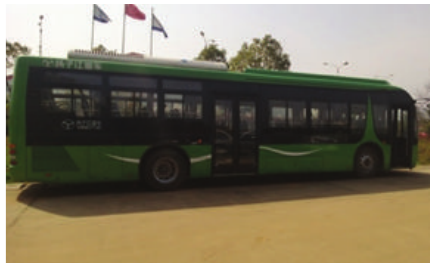
Figure 15: The test PHEB with